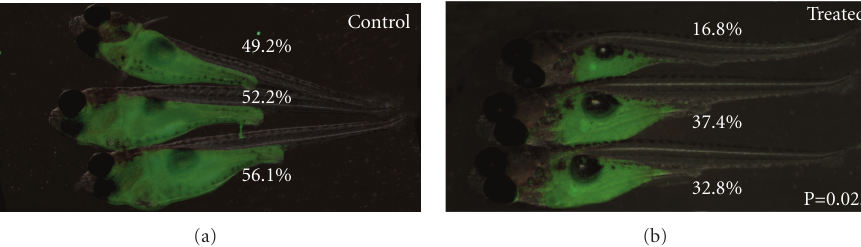
Figure 3: Syngeneic zebrafish transplant models of T-ALL are a powerful tool for drug discovery: T-ALL growth is suppressed by cyclophosphamide treatment. Approximately 200 cells/5 nL were engrafted into 5-day-old syngeneic CG2 larvae. Engrafted animals were treated with cyclophosphamide (400 mg/L dissolved in fish water) beginning 5 days posttransplantation. Images of control (a) and treated animals. (b) Tumor growth was assessed based on the percentage of body taken over by GFP+ T-ALL and compared using t -test calculations. This work was performed in [31] and later published in